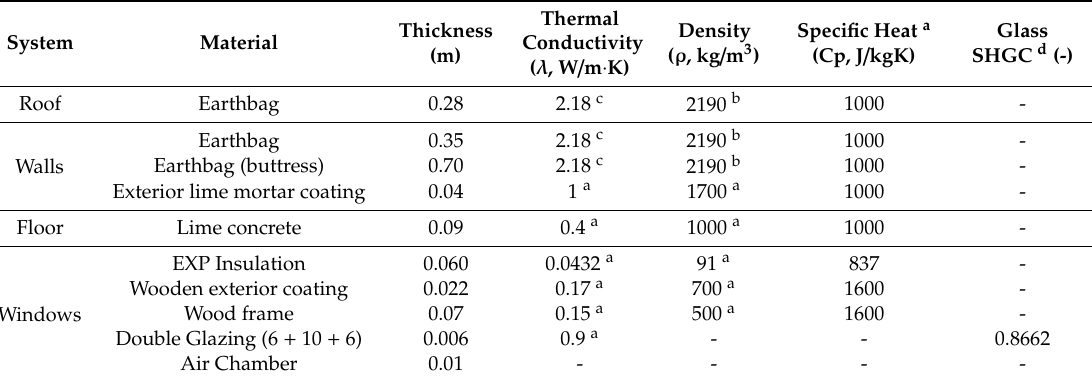
Figure 1. Earthbag building, University of Lleida Campus, Spain. Table 1. Materials properties of the Earthbag building.